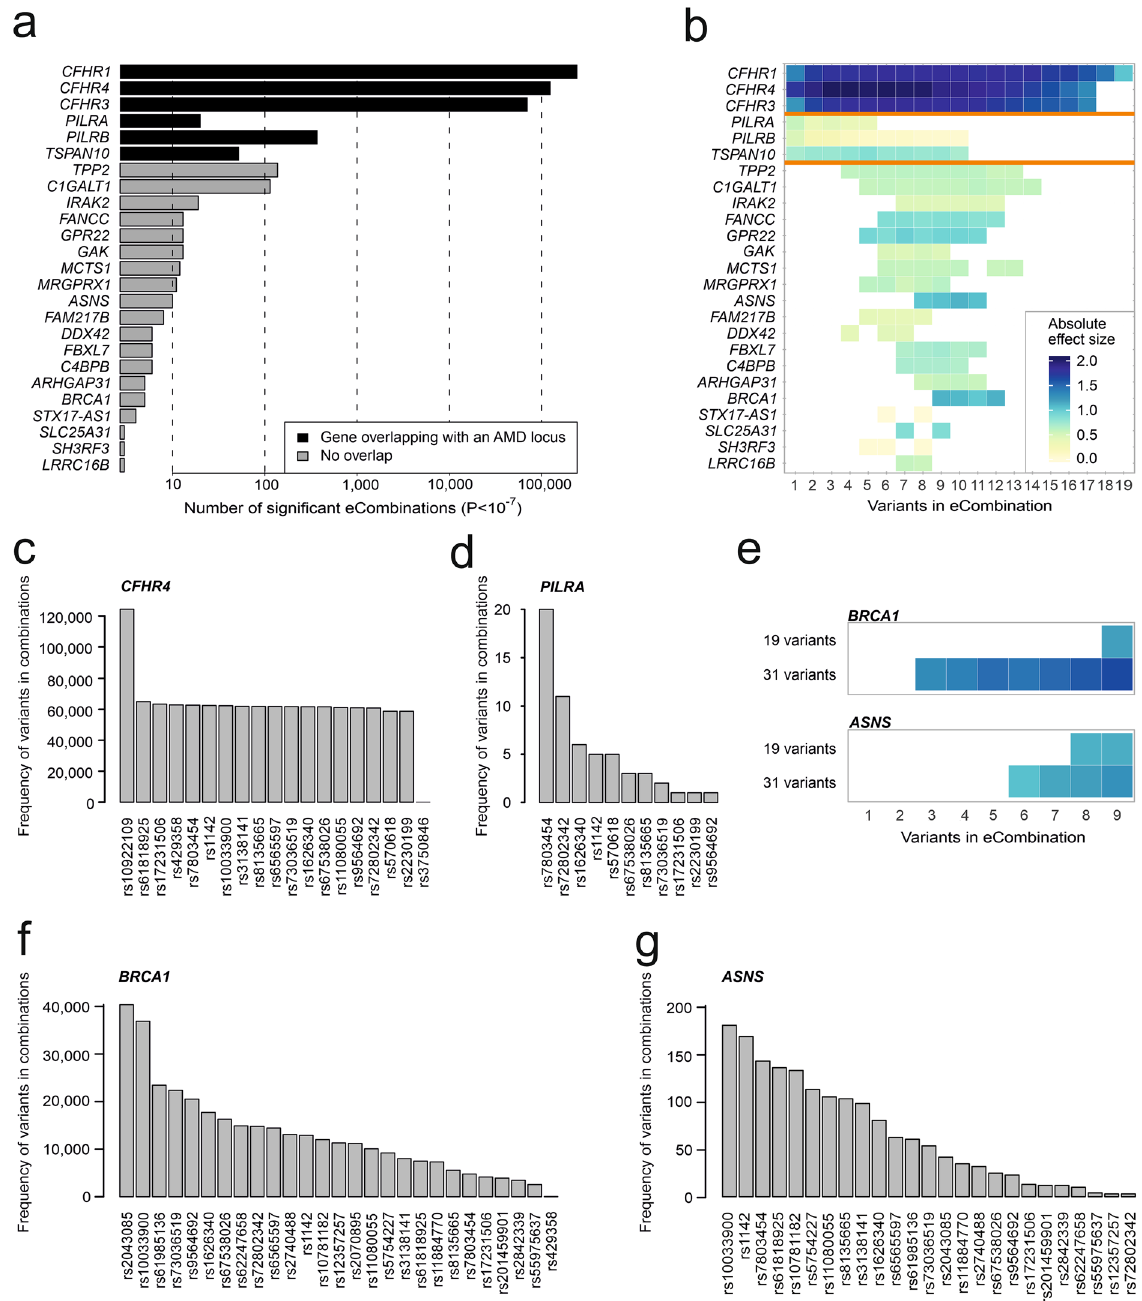
Figure 4. Interaction of genetic variants assigned to the immune pathway . ( a ) Number of eCombinations (P-value < 10 –7 ) influencing the expression of the respective eGene given on the Y-axis. eCombinations were generated from genetic variants assigned to the immune pathway by Fritsche et al. 2 and only eGenes which were detected at least three times are shown. Applying these thresholds, 438,219 significant results were obtained and related to expression changes of 25 eGenes. Black bars highlight eGenes that overlap with a known AMD locus 2 . ( b ) Color-coded effect sizes (ES) reflecting the correlation of eCombinations and gene expression. Colored fields show the absolute ES of an eCombination. White fields indicate a non-significant combination. The X-axis displays the number of genetic variants included in the respective eCombination. The orange line separates three subtypes of results, specifically one group including the CFH -related genes with one genetic variant being sufficient for eQTL detection and high absolute ES (highest absolute ES > 1.8), one group with a single genetic variant being sufficient for eQTL detection but lower ES (highest absolute ES < 1), and one group where an effect on gene expression can be observed by combining several genetic variants. ( c , d ) Contribution of different genetic variants to combinatory effects on gene expression of CFHR4 ( c , 124,372 eCombinations) and PILRA ( d , 20 eCombinations). ( e ) Comparison of testing combinatory effects of all 31 AMD-associated variants and testing combinatory effects of 19 variants assigned to the category immune system process. The heatmap functionally refers to ( b ). ( f , g ) Contribution of different variants to combinatory effects on gene expression of BRCA1 ( f , 40,903 eCombinations) and ASNS ( g , 192 eCombinations) with all 31 variants included in the analysis. Results refer to a P-value threshold < 10 –7